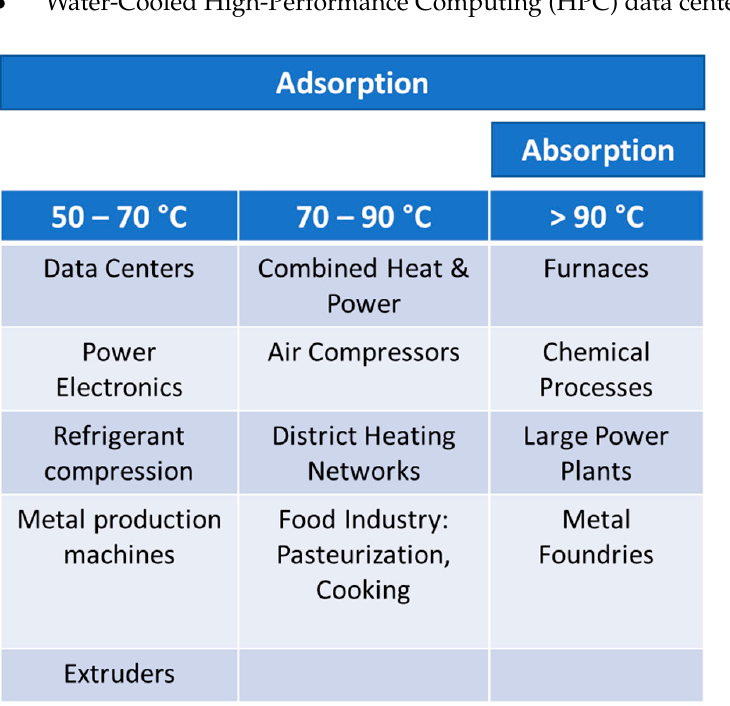
and is expected to increase to USD 2.18 billion by 2025 with an annual growth rate of 5.30%, which is higher than for compression chillers [28]. The portion of the European market is similar to the compression chiller